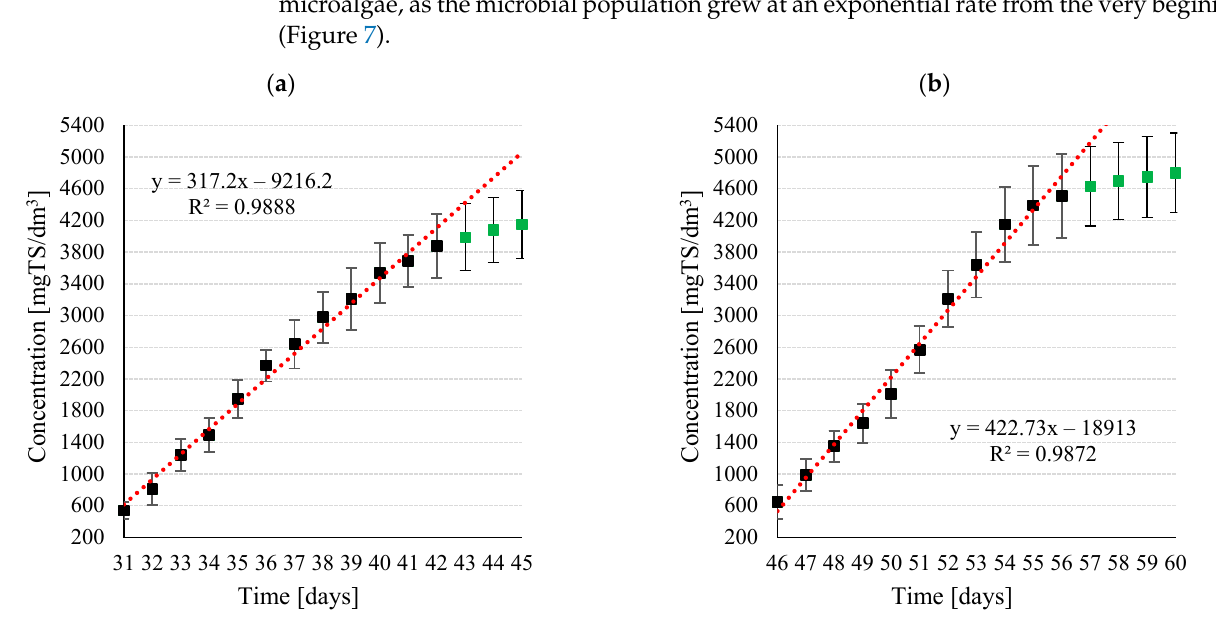
Figure 6. M-BGS biomass production in phases: ( a ) phase 1 (days 1–15) and ( b ) phase 2 (days 16– 30) of the H-PBR operation.